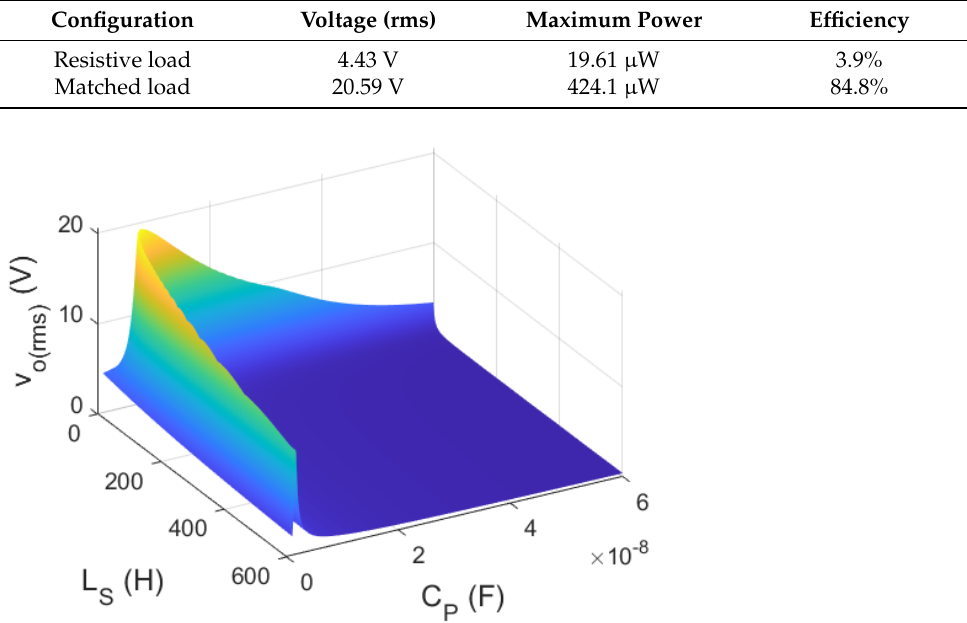
Figure 3. Root mean square of the output voltage as a function of the matching network parameters L S and C P